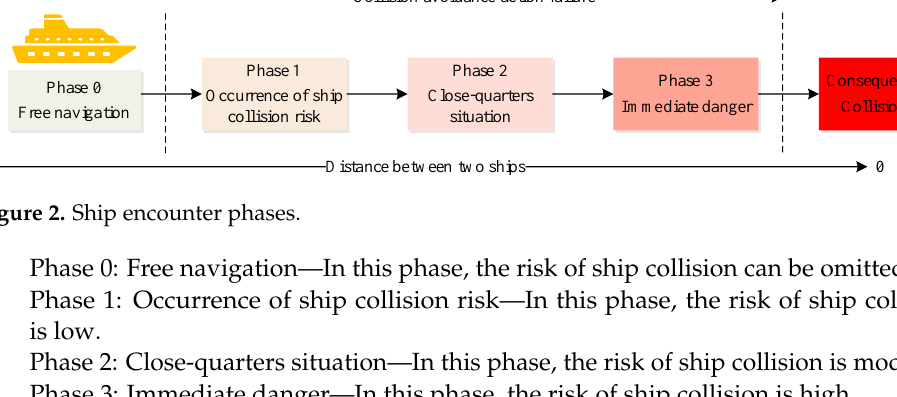
Figure 1. Research framework.